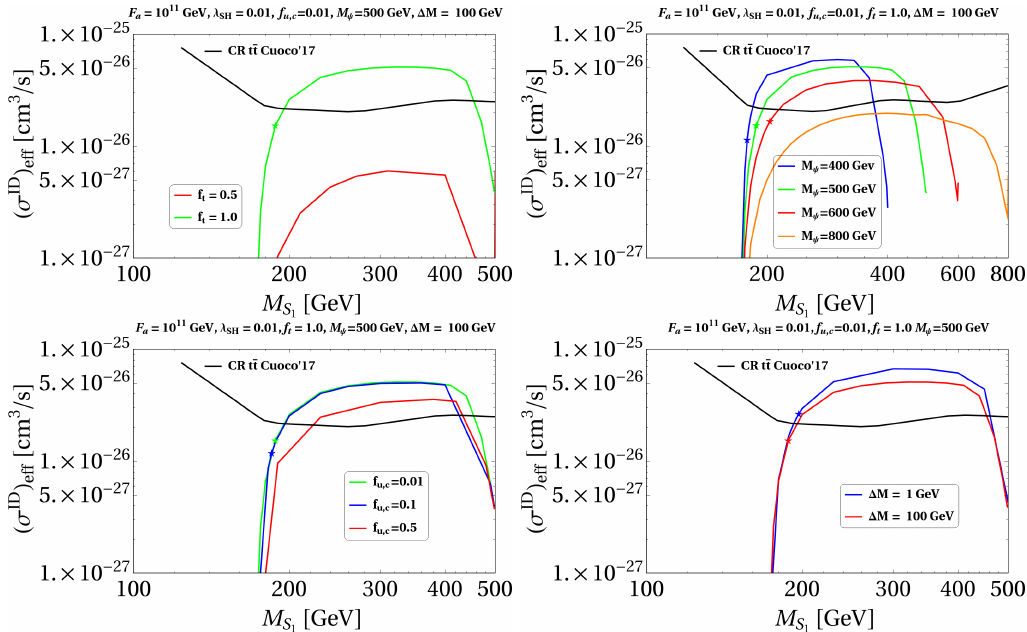
JHEP12(2022)167 Figure 3. Variation of effective indirect detection cross-section versus DM mass. Variation for different values of f , the mass of VLQ, f , and ∆ M are shown in top left, top right, bottom left t u,c and bottom right panels respectively. In all the plots we fix F = 10 11 GeV , λ = 0 . 01 . The solid a SH black line shows the experimental upper bound in t ¯ t final